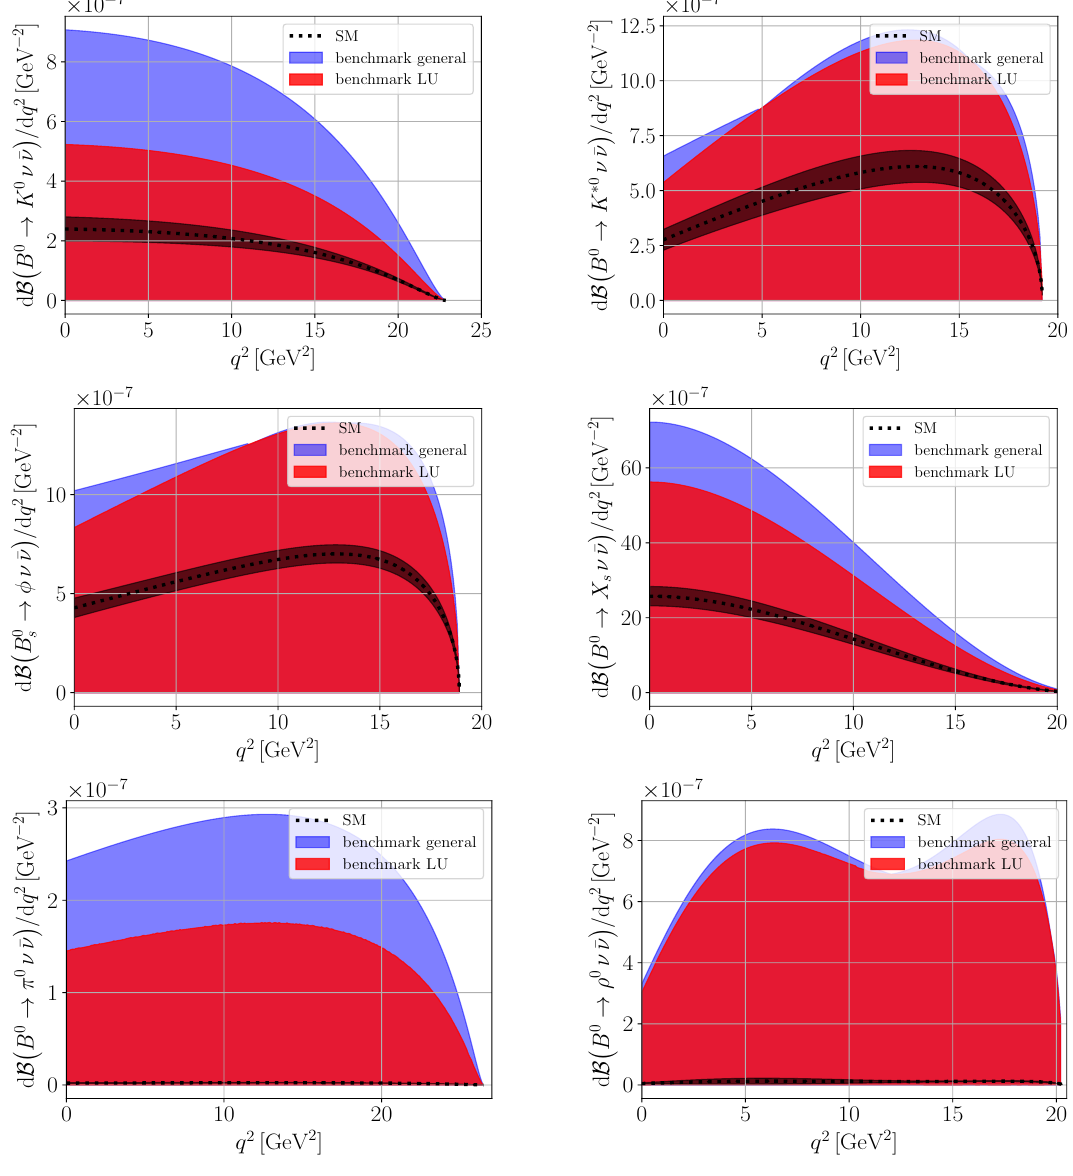
Figure 4 . Differential branching ratio for B 0 → K 0 ν ¯ ν , B 0 → K ∗ 0 ν ¯ ν , B 0 B 0 → π 0 ν ¯ ν , and B 0 → ρ 0 ν ¯ ν in the SM and two NP benchmark scenarios, “benchmark general” using the derived EFT bounds (4.1) and (4.2) for b → s ν ¯ ν and b → d ν ¯ ν , respectively, and “bench- mark LU” (3.1) together with the experimental limits from table 2. See text for